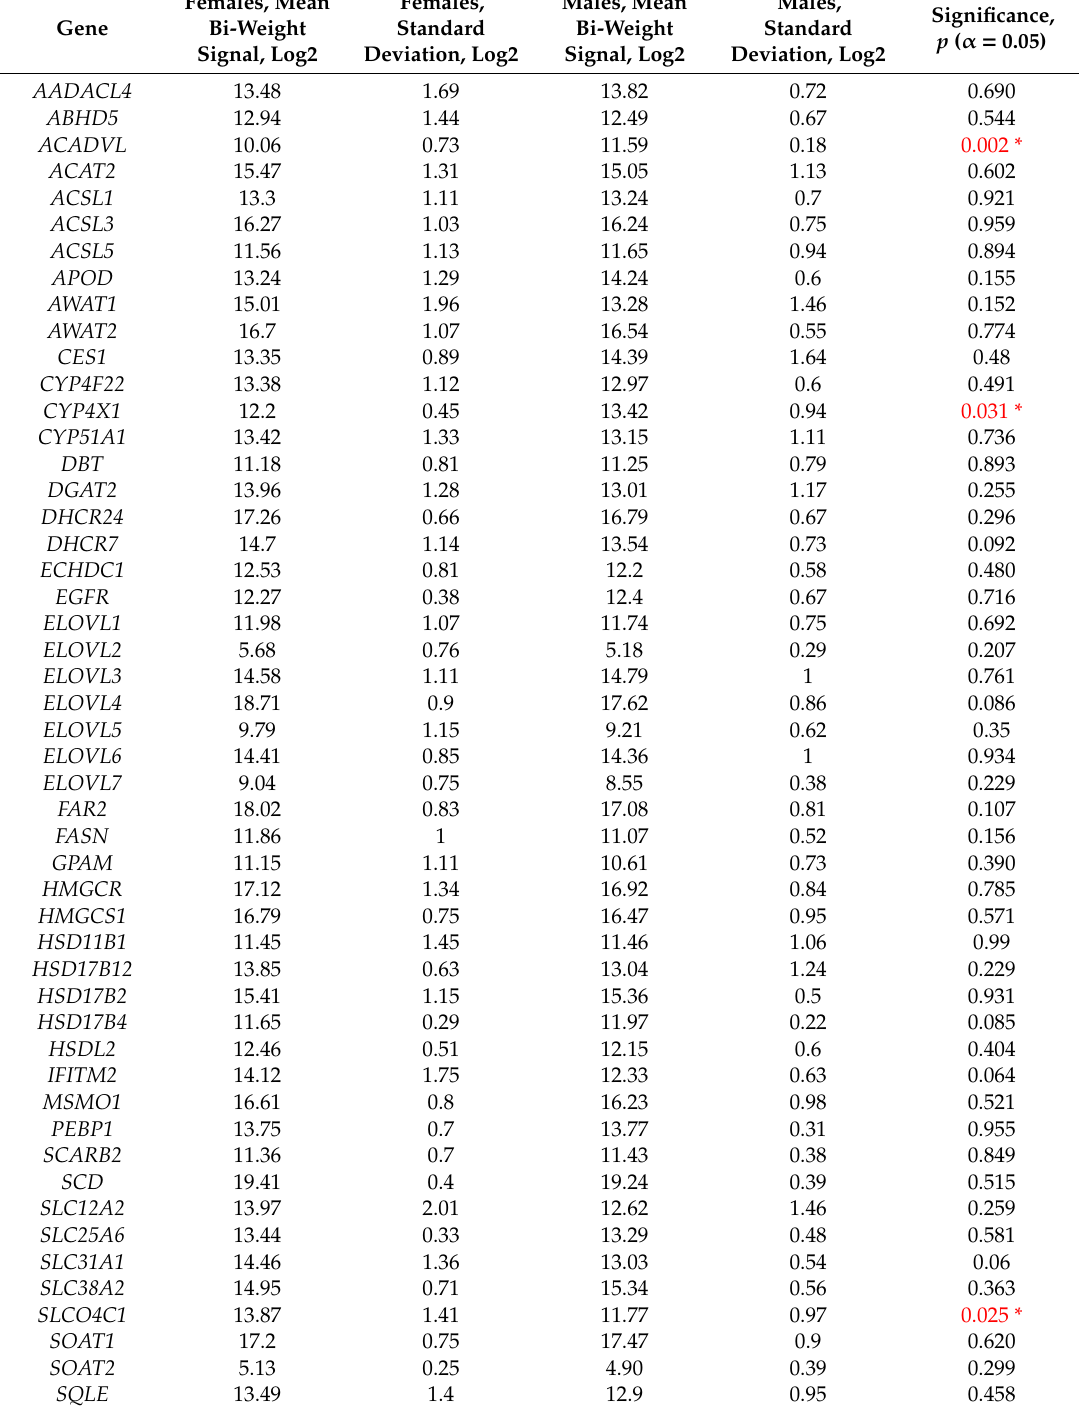
Top 50 expressed protein-coding genes detected in (TP + MG) tarsal plate samples of both genders using targeted transcriptomic analysis ( n = 10; 5 males and 5 females; averaged data). Statistically significant di ff erences are shown in red and labeled with an asterisk